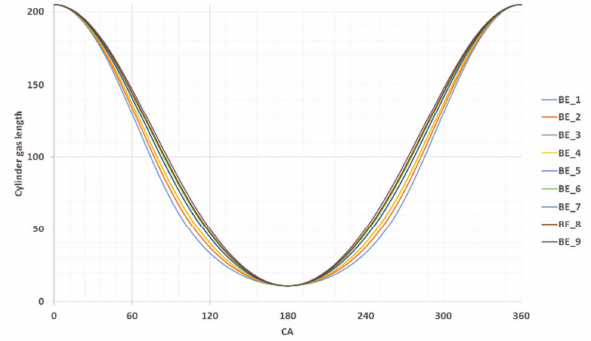
Fig. 13. BE piston motion curves